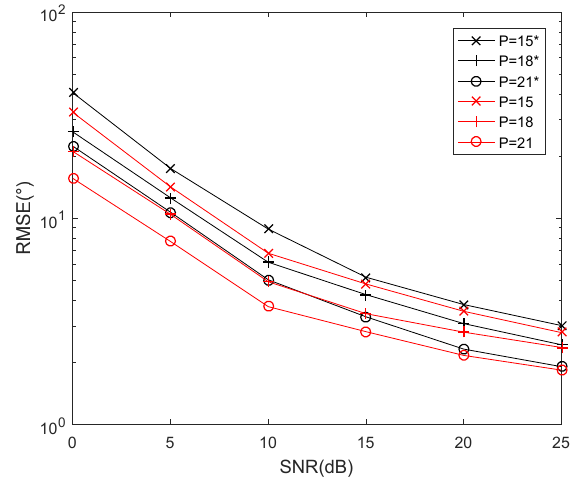
Figure 15. RMSE performance of η versus SNR.